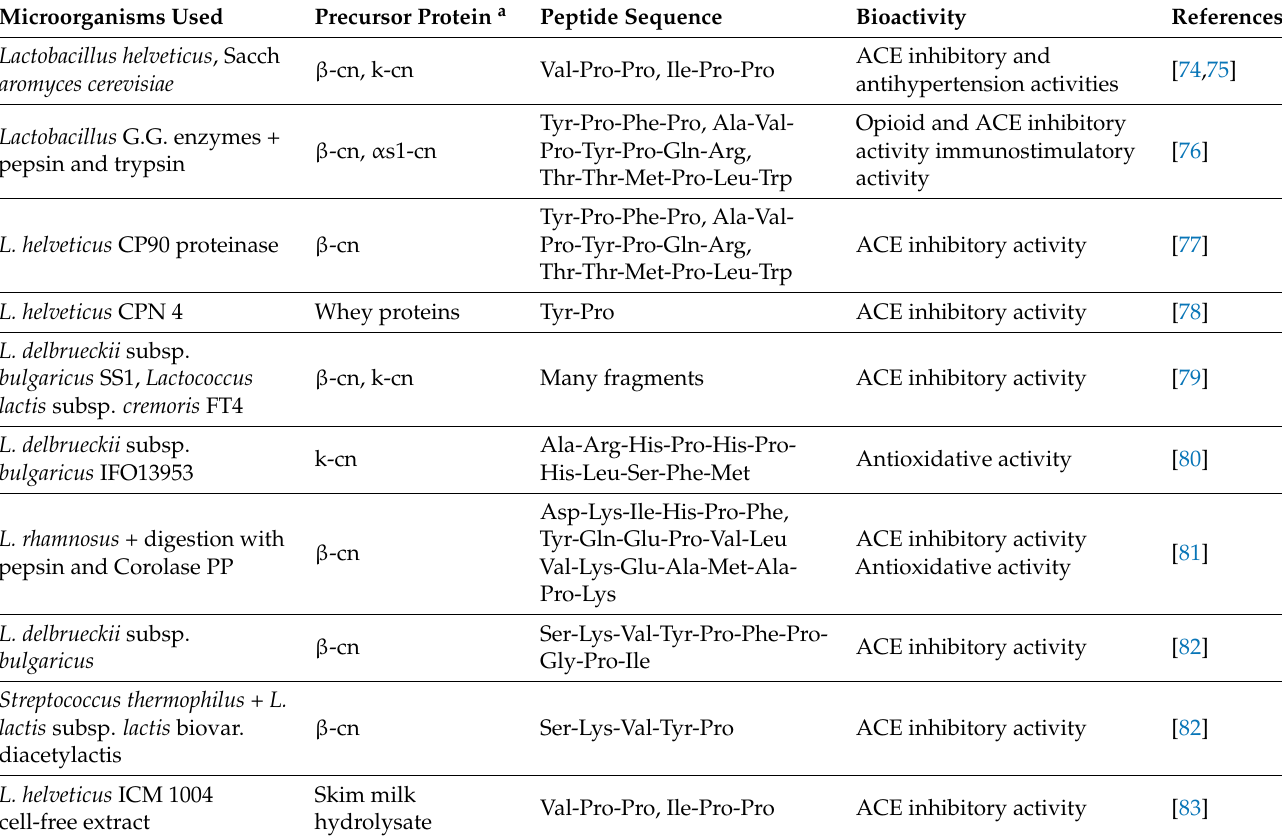
Table 4. Enzymes applied in the production of bioactive peptides by enzyme